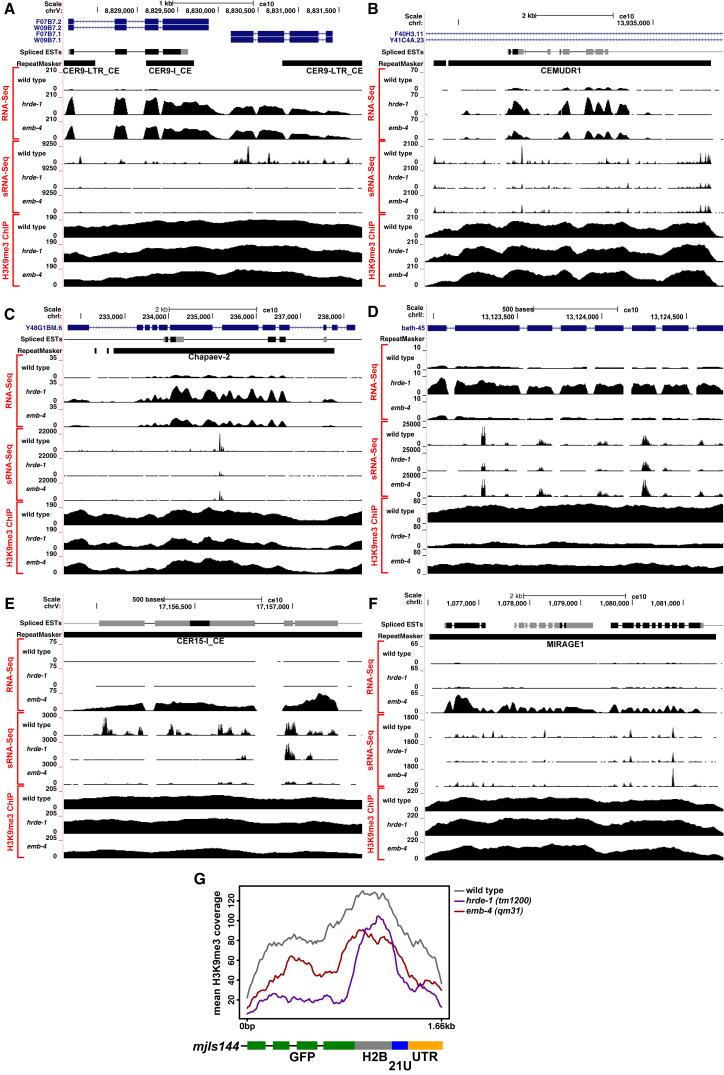
Exemplary Upregulated Regions with mRNA, 22G-RNA, and H3K9me3 Chromatin IP Profiles in hrde-1 and emb-4 Mutants(A–F) CER9-LTR_CE/CER9-I_CE retro-elements (A), CEMUDR1 transposable element (B), Chapaev-2 transposable element (C), piRNA target gene bath-45 (D), CER15-I_CE retro-element (E), and Mirage1 transposable element (F). Repeatmasker tracks show transposable elements, and spliced EST tracks show evidence for canonical introns (UCSC genome browser).(G) H3K9me3 chromatin IP profile of piRNA sensor transgene.